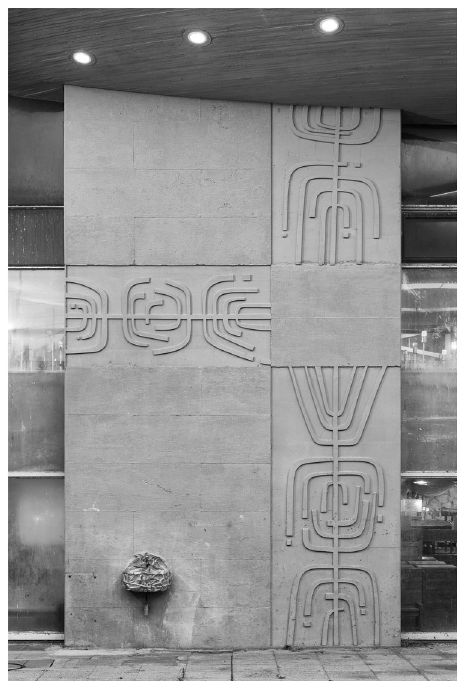
Fig. 8 Artworks at the Central Synagogue in Nazareth Illit: Ruth Zarfati and Moshe Sternschuss, a bronze basin, ca. 1968, and Ruth Zarfati, relief, ca. 1968 (Photo: Eli Singalovski, 2018).